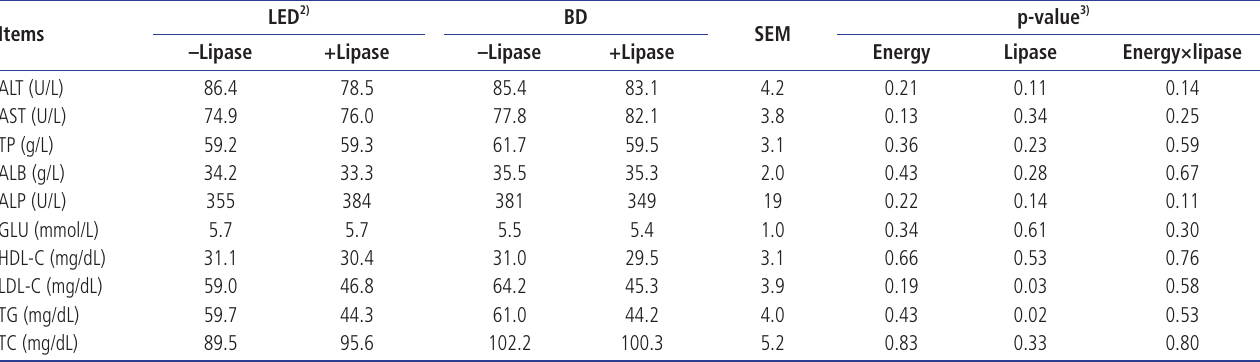
Table 4. Effects of dietary energy and lipase levels on serum profiles in weaning pigs 1)